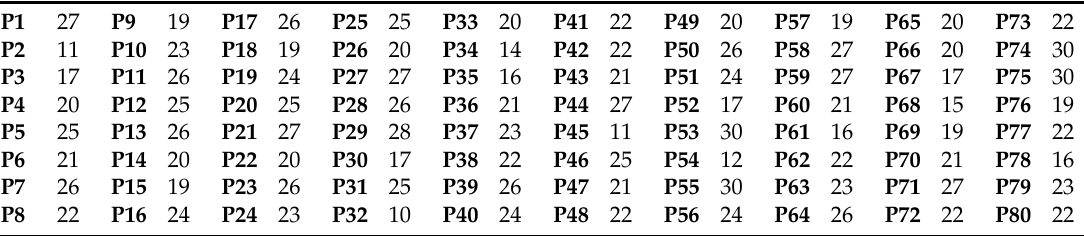
Table 4. Workloads of each personnel with manual scheduling.